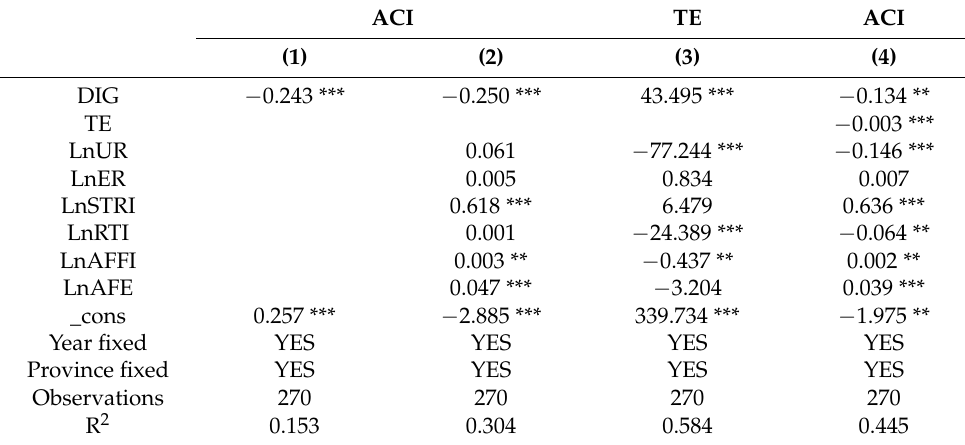
Table 5. Benchmark regression and mechanism test results of digital economy influencing agricultural carbon